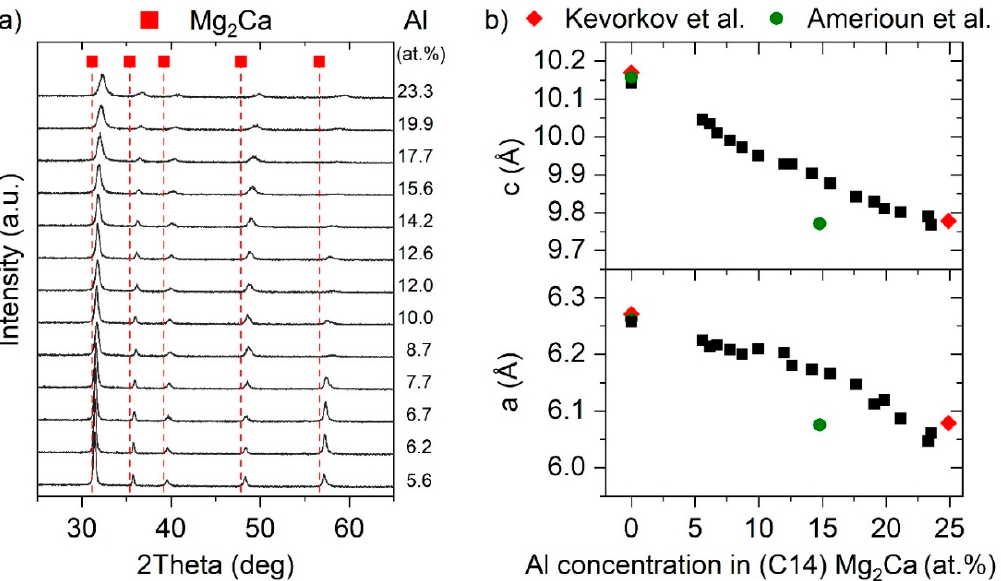
Figure 4. ( a ) Diffractograms of the Mg-rich ternary thin films with varying Al concentration deposited at 200 °C. ( b ) Calculated lattice parameters a and c of hexagonal C14 Mg 2 Ca as a function of the Al concentration. Experimental values from literature are added for comparison (Kevorkov et al. [14] ; Amerioun et al. [11] ).